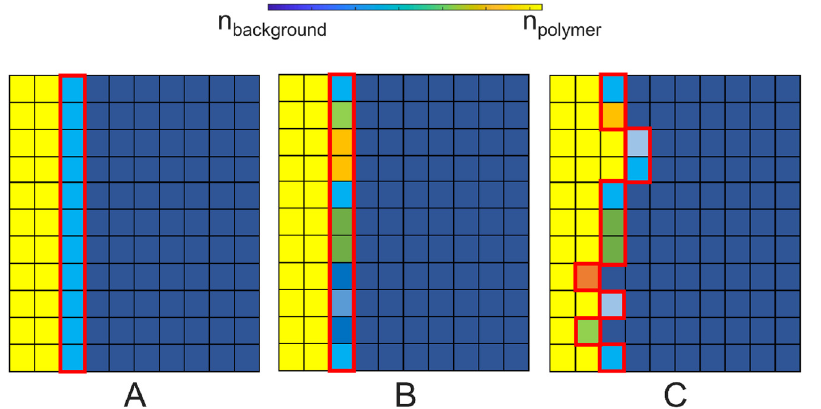
Figure 2: Representation of the optimization scheme on a single layer. (A) Initialization step with a uniform layer and active voxels (shown with red boundaries). (B) n th Iteration where we observe changes of refractive index in active voxels. (C) m th Iteration where we observe the elongation of active voxels. Provided that : m > n > 1.